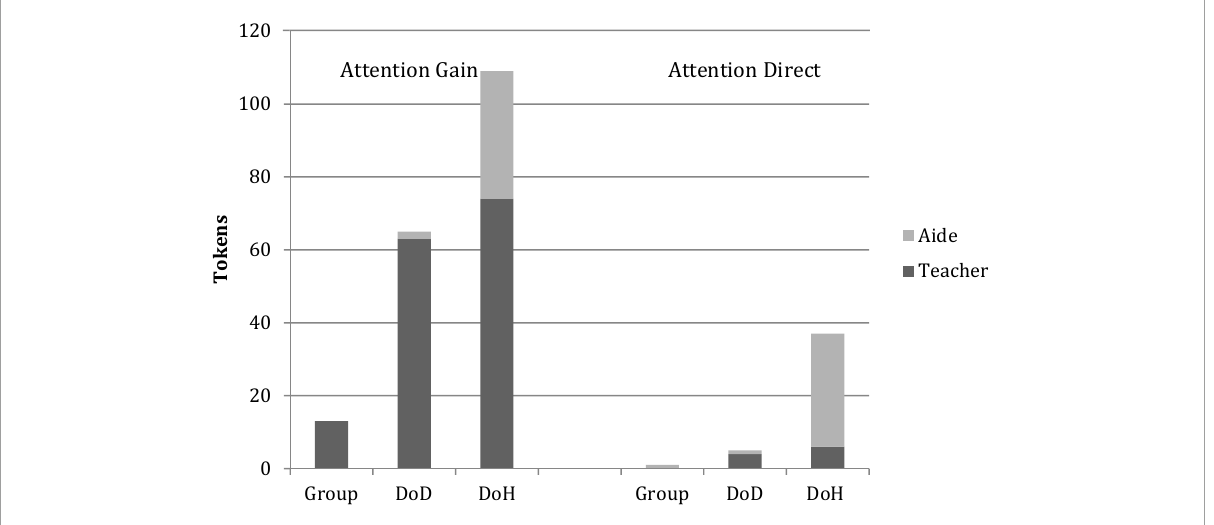
FIGURE1 Deaf preschool teachers’ overall tokens (collapsed across two book-sharing episodes) of Attention-Gaining and Attention-Directing Actions expressed toward the whole group of students, Deaf children of Deaf parents (DoD) and deaf children of hearing parents